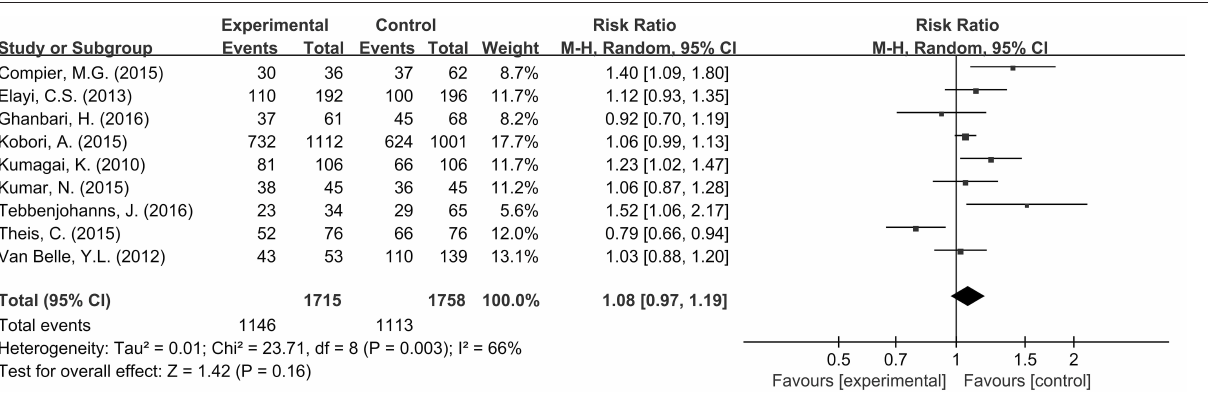
FIGURE 2 | Forest plot comparing long-term success rates of PVI between Group A ( + ) and Group A ( − ).